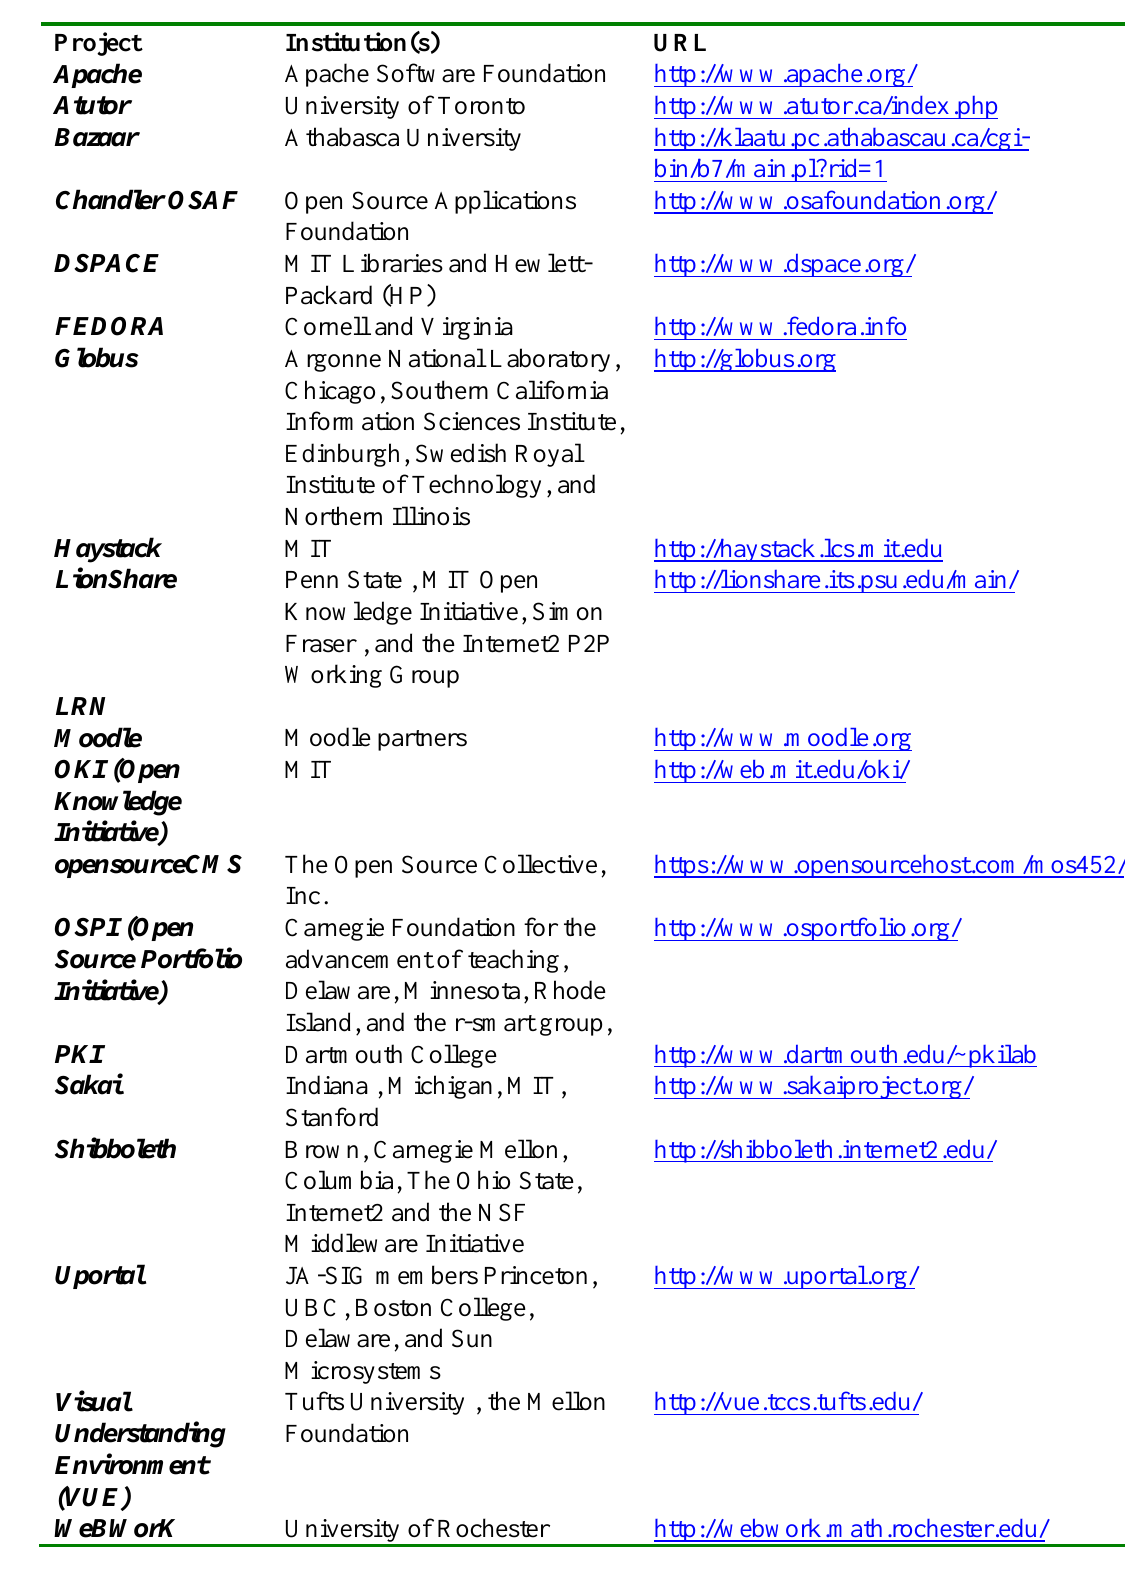
Table 1. The open-source offerings in North America Project URL Apache Apache Software Foundation Atutor Bazaar Chandler OSAF Open Source Applications Foundation